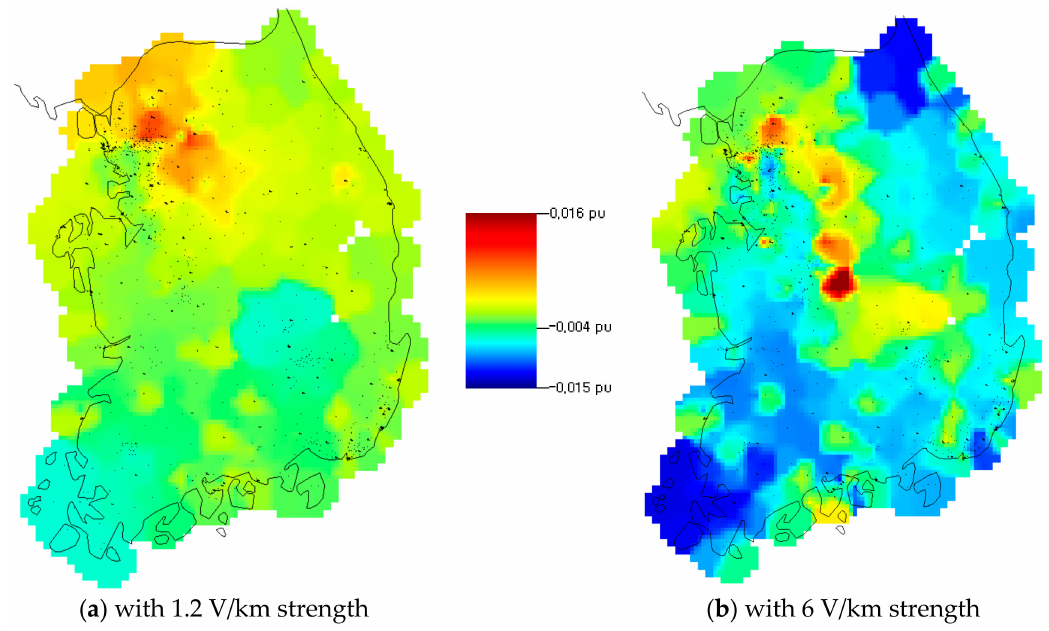
Figure 7. Contour plot of voltage differences before and after